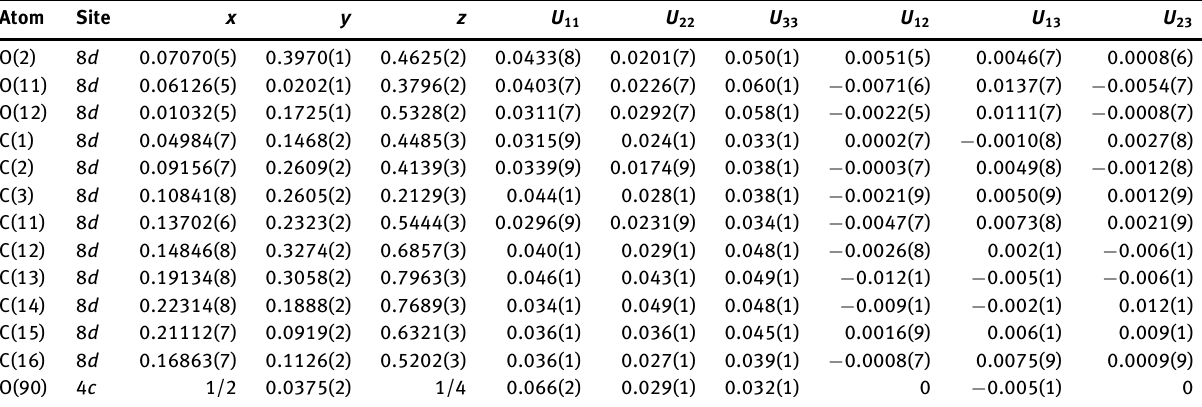
Table 3: Atomic coordinates and displacement parameters (in Å 2